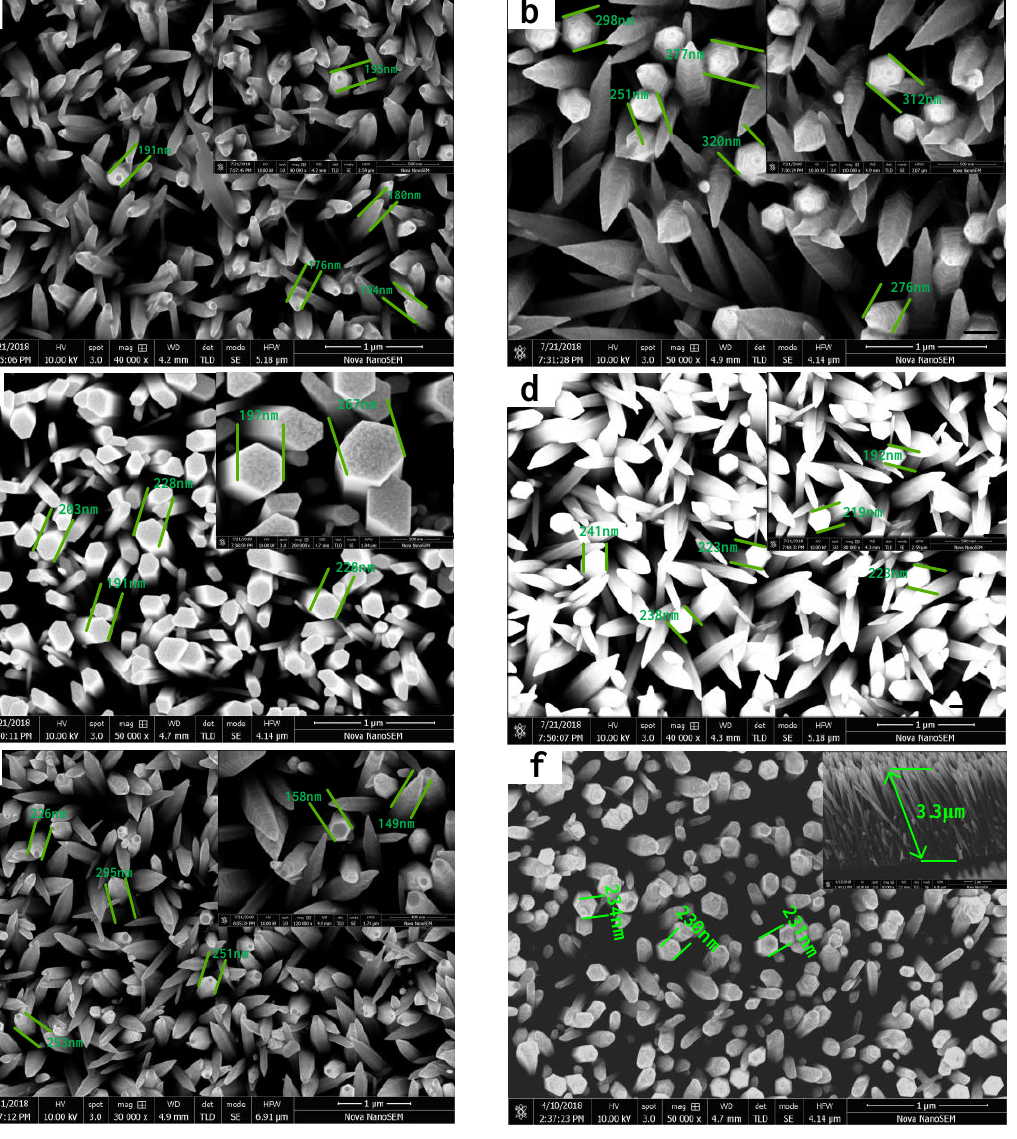
Figure 3. SEM of Zn 1-x Ni x O nanorod arrays. ( a ) 1 wt% Ni 2+ , ( b ) 2 wt% Ni 2+ , ( c ) 3 wt% Ni 2+ , ( d ) 4 wt% Ni 2+ , ( e ) 5 wt% Ni 2+ and ( f ) 0 wt% Ni 2+ .